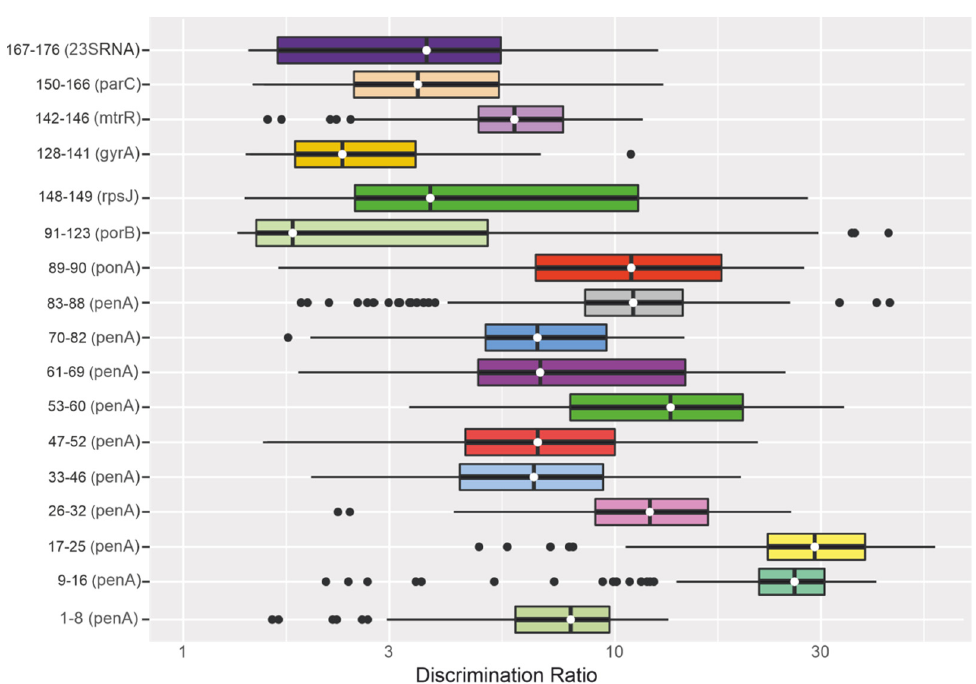
Figure 2. Box plot: Discrimination ratios in the groups of microarray elements, calculated as the ratio of the largest positive signal I p in the group to the next largest signal I m . The group numbers of microarray elements and the colors of the boxes correspond to those in Figure 1. Each box indicates the median I p /I m value for a group of elements, the lower (25th percentile) and upper (75th percentile) quartiles, the interquartile range, and data outliers (plotted as points). The whiskers extend to the boundaries of the interquartile range.